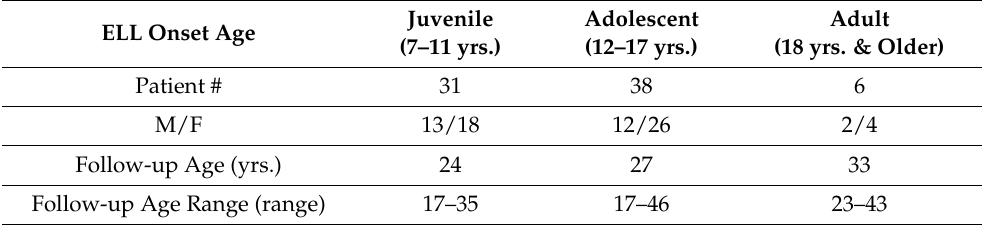
Table 3. Onset age demographics for ELL (extensive limb